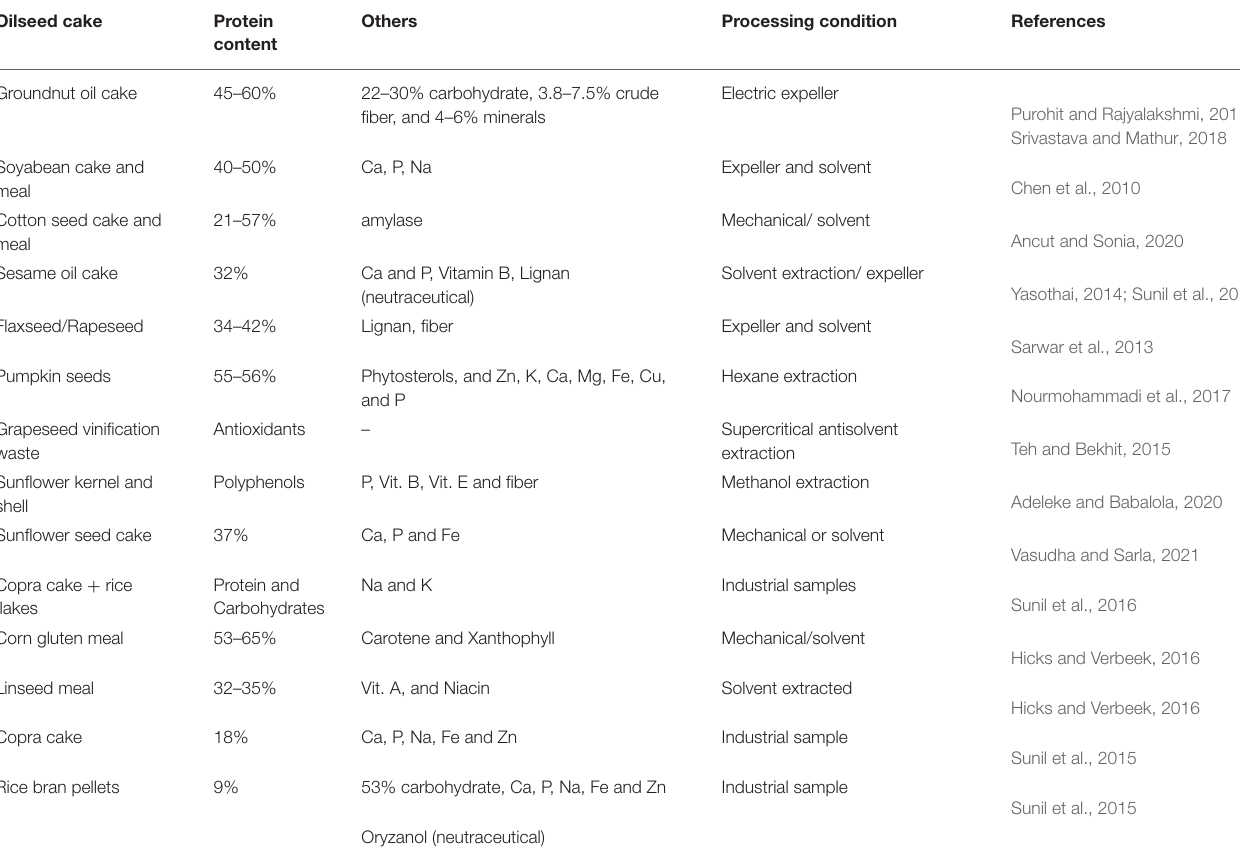
TABLE 2 | Different oilseed cakes and their protein contents and nutrition